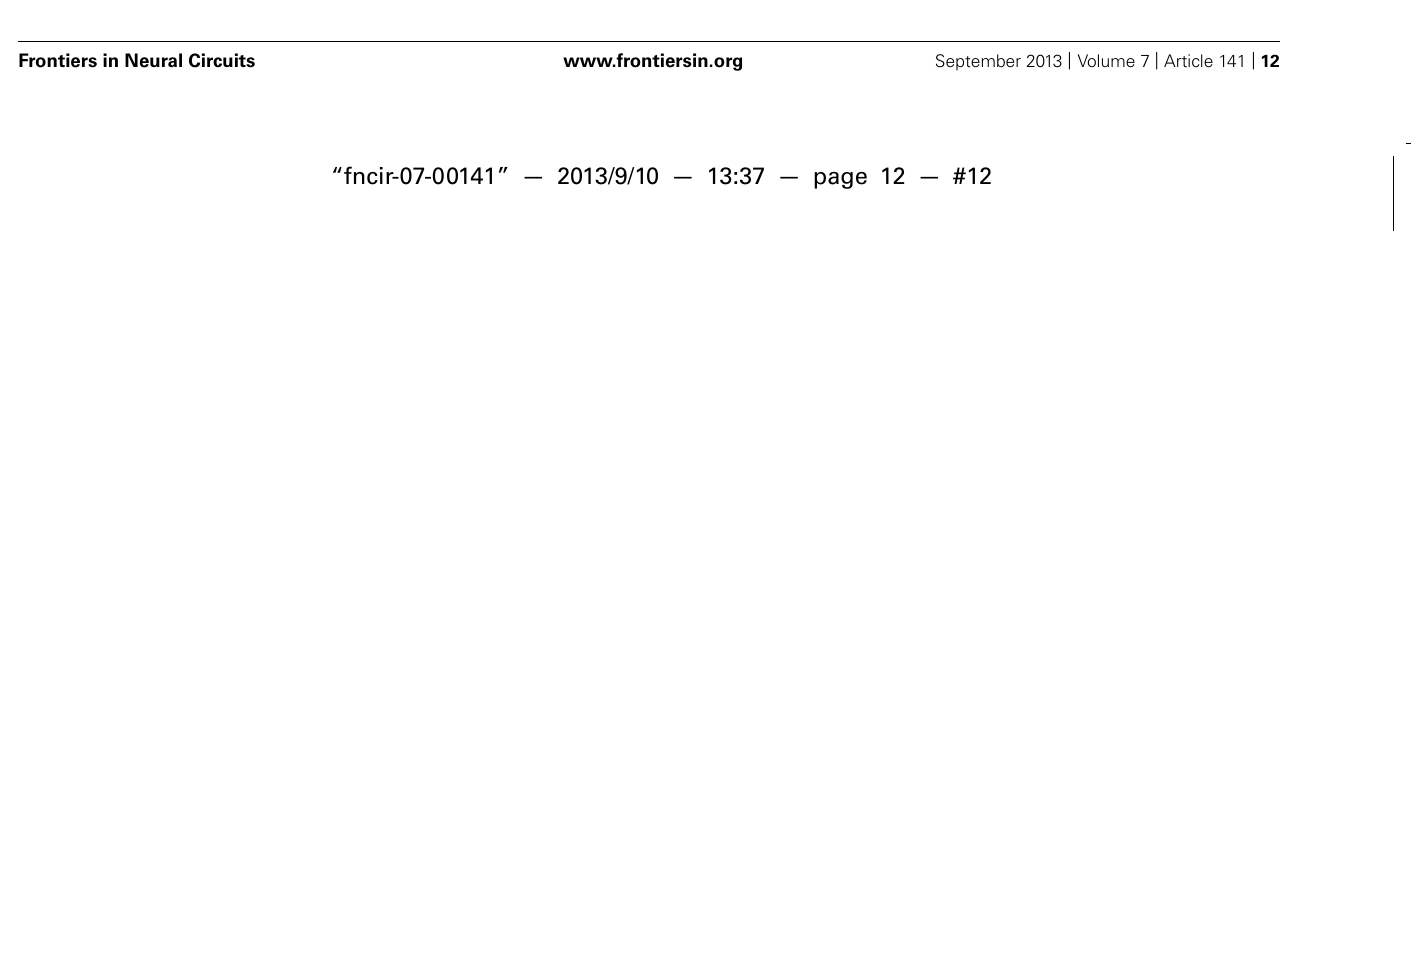
stimulus (dots connected by lines) versus sweep number. Inter-sweep interval was 620 ms.The sweeps marked by magenta circles are depicted in (A) (left to right corresponding top to bottom). (C) Scatter plot of correlation coefficients r var ( EM ) and r EM (see main text) for control and NO-711 conditions. Each pair of circles connected by a dotted line corresponds to one cell. Error bars are 95% confidence intervals. Note that the width of the error bars depends crucially on the number of injected current sweeps, which varied between the neurons and between drug conditions. (D) Spike counts, averaged over all sweeps during control and 250 nM NO-711, for the same cells as depicted in (C) (means ± sd). Each pair of connected gray open circles represents one cell. (E) Spike counts from five additional neurons sequentially exposed to muscimol and NO-711 (same as depicted in Figure 6B ). Same conventions as in (D)